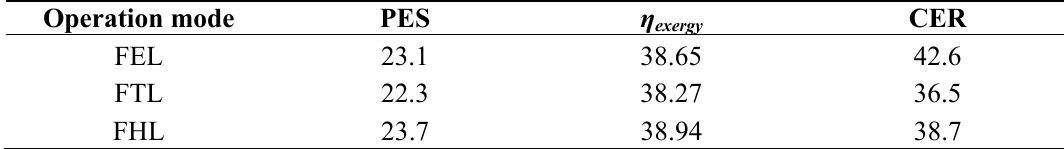
Table 4. Annually operation parameters of CCHP system (unit: